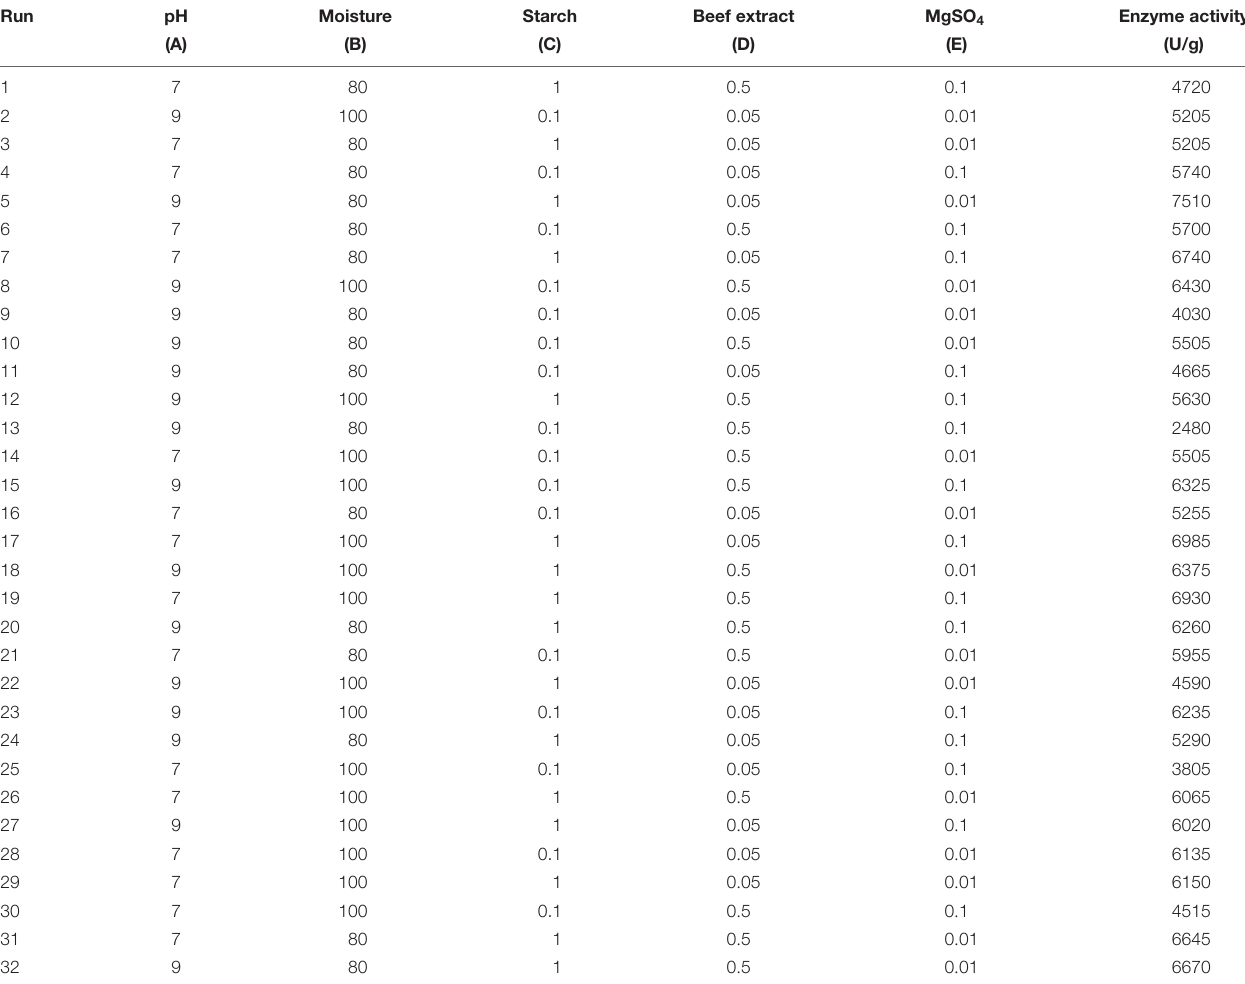
TABLE 2B | Two-level full factorial matrix for screening of variables for fibrinolytic enzyme production from Bacillus sp. IND7. Run pH Moisture Starch Beef extract MgSO 4 Enzyme